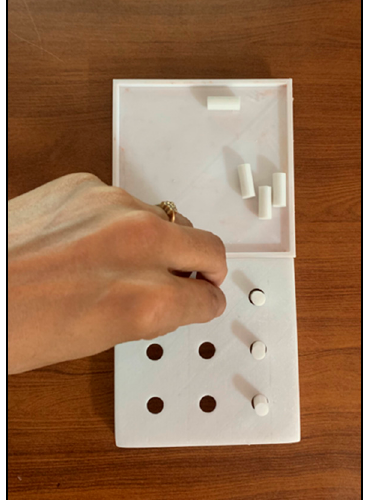
Figure 6. Subject performing the Nine-hole peg test .